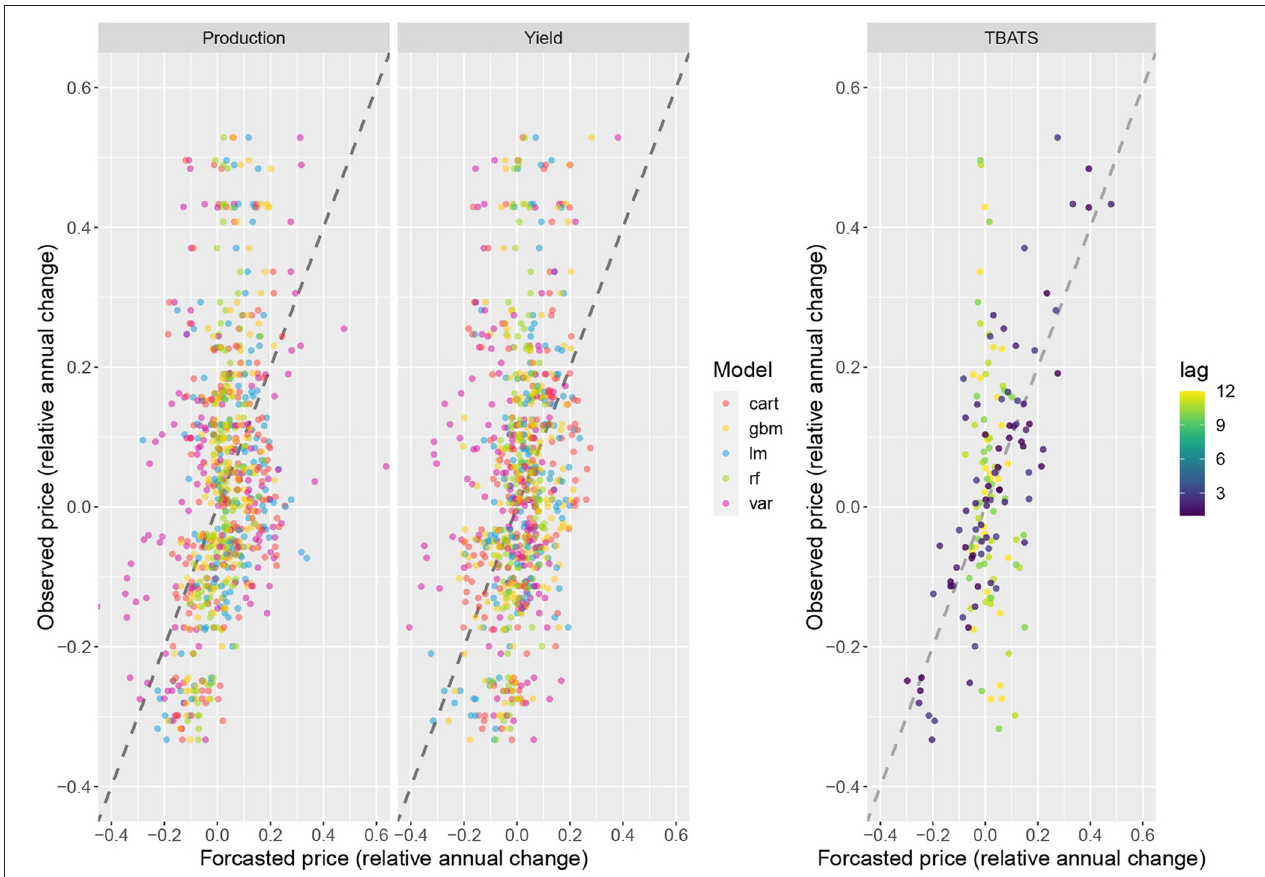
FIGURE 2 | Maize global price change: observed vs. forecasted, as obtained with all models. CART, RF, GBM, LM, and VAR are shown on the left. The TBATS forecasts are displayed on the right for time lag ranging from 1 to 12 months. The dashed black lines are the 1:1 lines (lines of